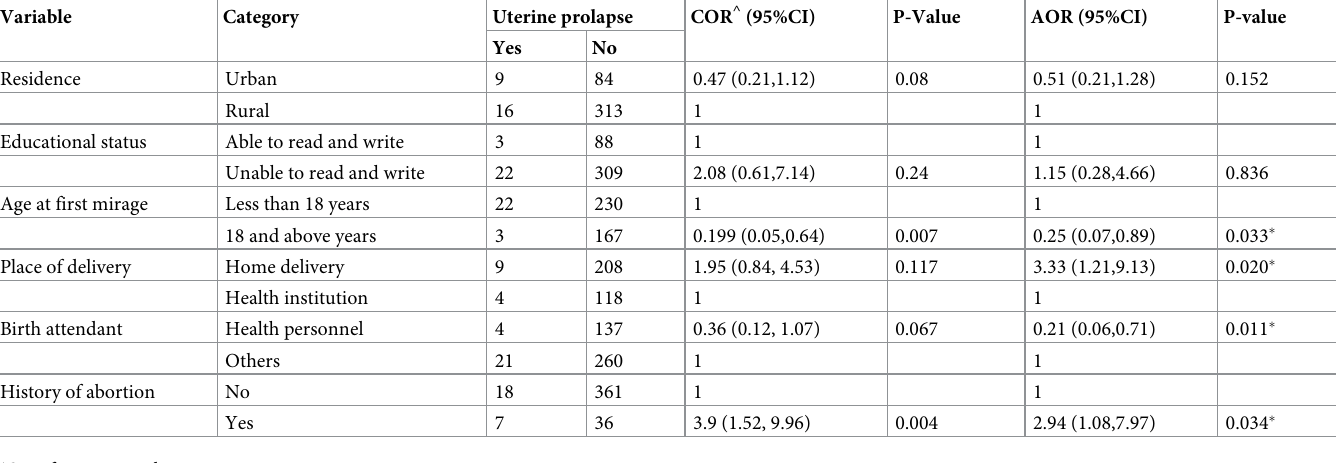
Table 4. Factors associated with the prevalence of uterine prolapse in the Loma Woreda, Dawuro Zone, Ethiopia 2020 (n = 422).